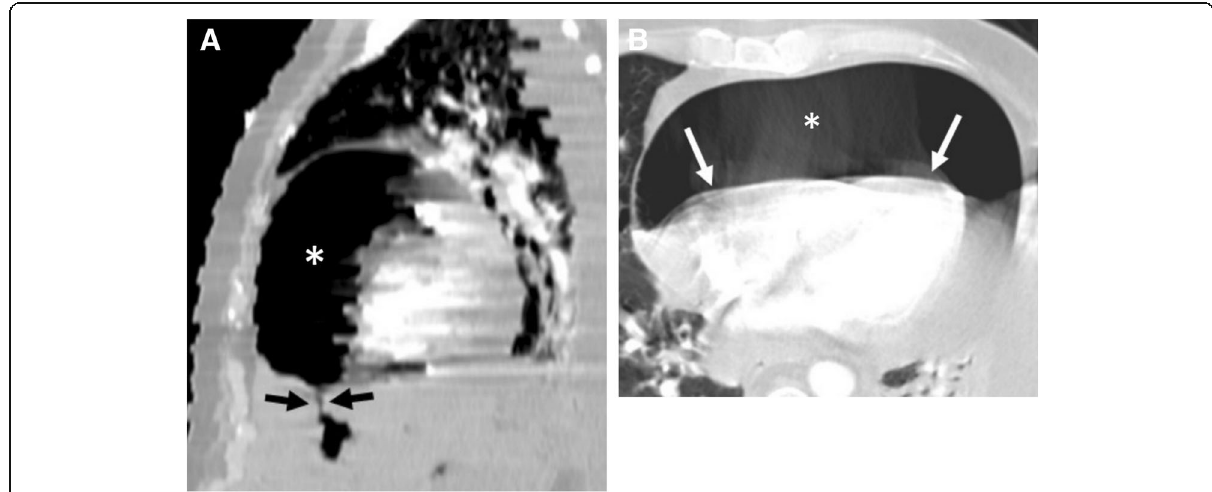
Fig. 4 A 51-year-old man with pathologically proven gastric lymphoma developed sudden onset of dyspnea and cardiac arrhythmia. Contrast-enhanced CT in the sagittal ( a ) and axial ( b ) planes demonstrates a gastropericardial fistula (black arrows) complicated with massive pneumopericardium (asterisks). Significant compressive effect to the heart is also noted (white arrows)